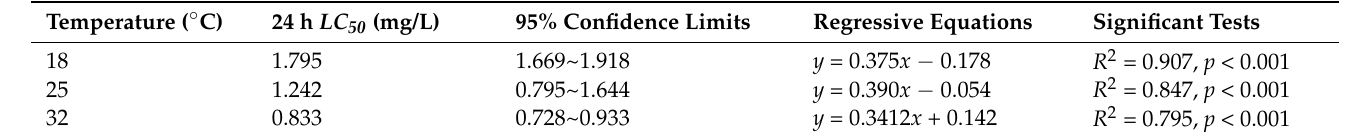
Table 1. The 24 h LC 50 of chlorpromazine as well as the relationships between chlorpromazine concentration ( x , mg/L) and mortality rate of B. calyciflorus at three temperatures. Shown are the mean ± standard error based on three